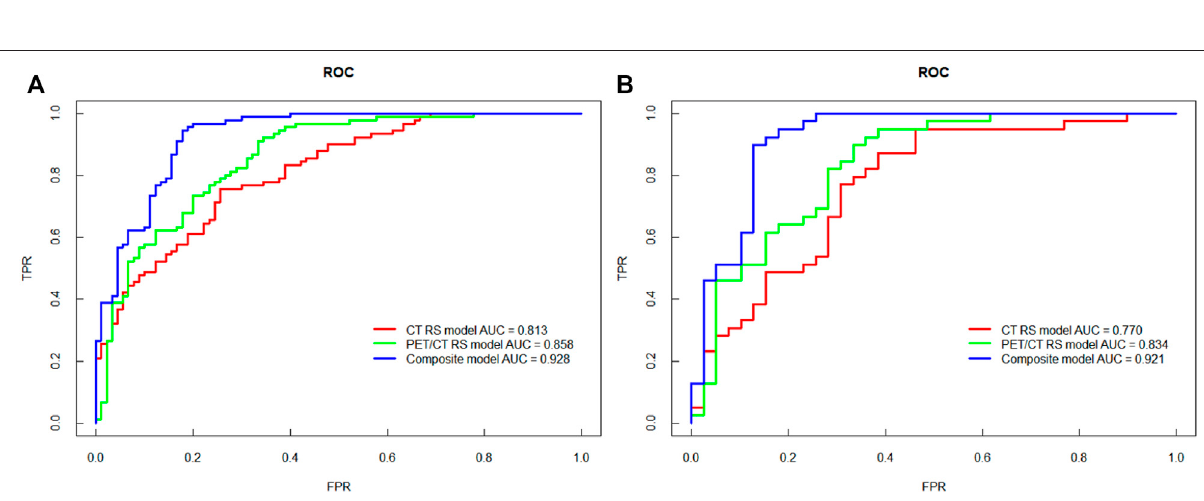
FIGURE 3 | ROC curves of the three models for predicting KRAS mutations. (A) The ROC curve of the training cohort. (B) The ROC curve of the validation cohort.